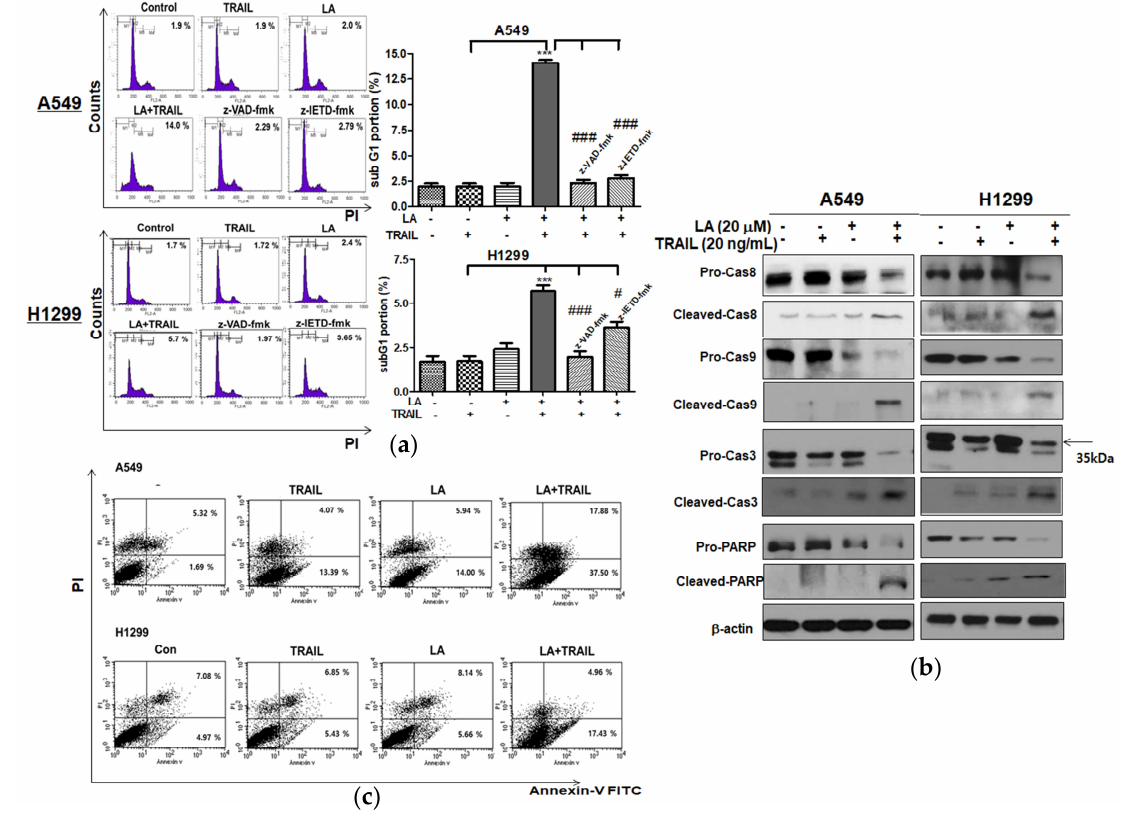
Figure 2. Combined effect of LA and TRAIL on the sub-G1 population and apoptotic proteins in A549 and H1299 non-small cell lung cancer cells. ( a ) Cells were treated with LA (20 µ M) and/or TRAIL (20 ng/mL) for 24 h. The treated cells were fixed with 70% ethanol, stained with propidium iodide (PI) and analyzed by flow cytometry with or without with caspase inhibitors (pan caspase inhibitor; z-VAD-fmk (80 µ M), caspase-8 inhibitor; z-IETD-fmk (50 µ M)). Bar graphs show quantification of cell cycle population (%). Data represent means ± SD. *** p < 0.001 versus TRAIL alone, # p < 0.05, ### p < 0.001 versus LA+TRAIL treated control. ( n = 3)). ( b ) Cells were treated with LA (20 µ M) and/or TRAIL (20 ng/mL) for 24 h. Cell lysates were prepared and subjected to Western blotting for procaspase-8,9,3, Pro-PARP, cleaved caspase-8,9,3, and cleaved-PARP. ( c ) Cells were treated with LA (20 µ M) and/or TRAIL (20 ng/mL) for 24 h. The cells were stained using FITC-Annexin V/PI dye and early and late apoptotic portions were detected by flow